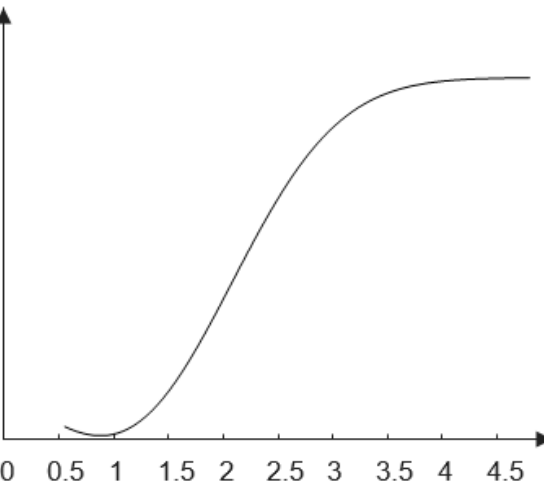
Figure 5. Relationship between average expected compensation g and optimal solution λ .